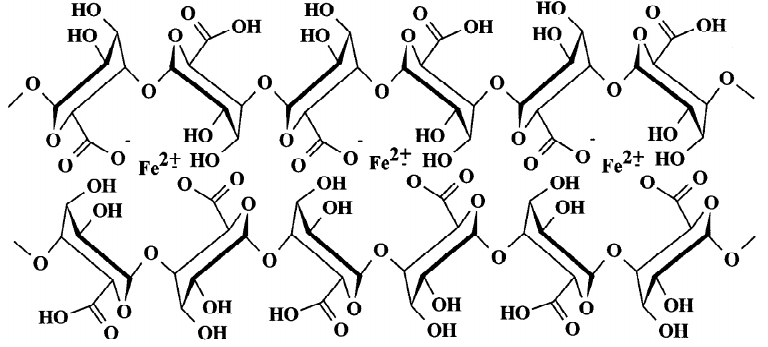
Figure 2. Representation of two 1,4-linked α- L -guluronic acid (G)-blocks forming an “egg box” structure with ferrous ions. Reprinted with permission from [9]. Copyright 2000 Elsevier Science